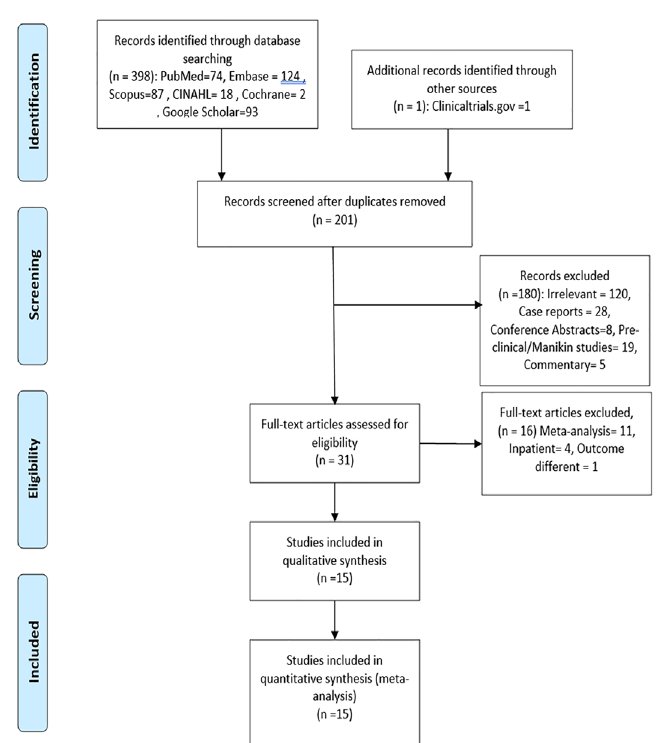
Figure 1. Preferred Reporting Items for Systematic Reviews and Meta-Analyses (PRISMA) flow